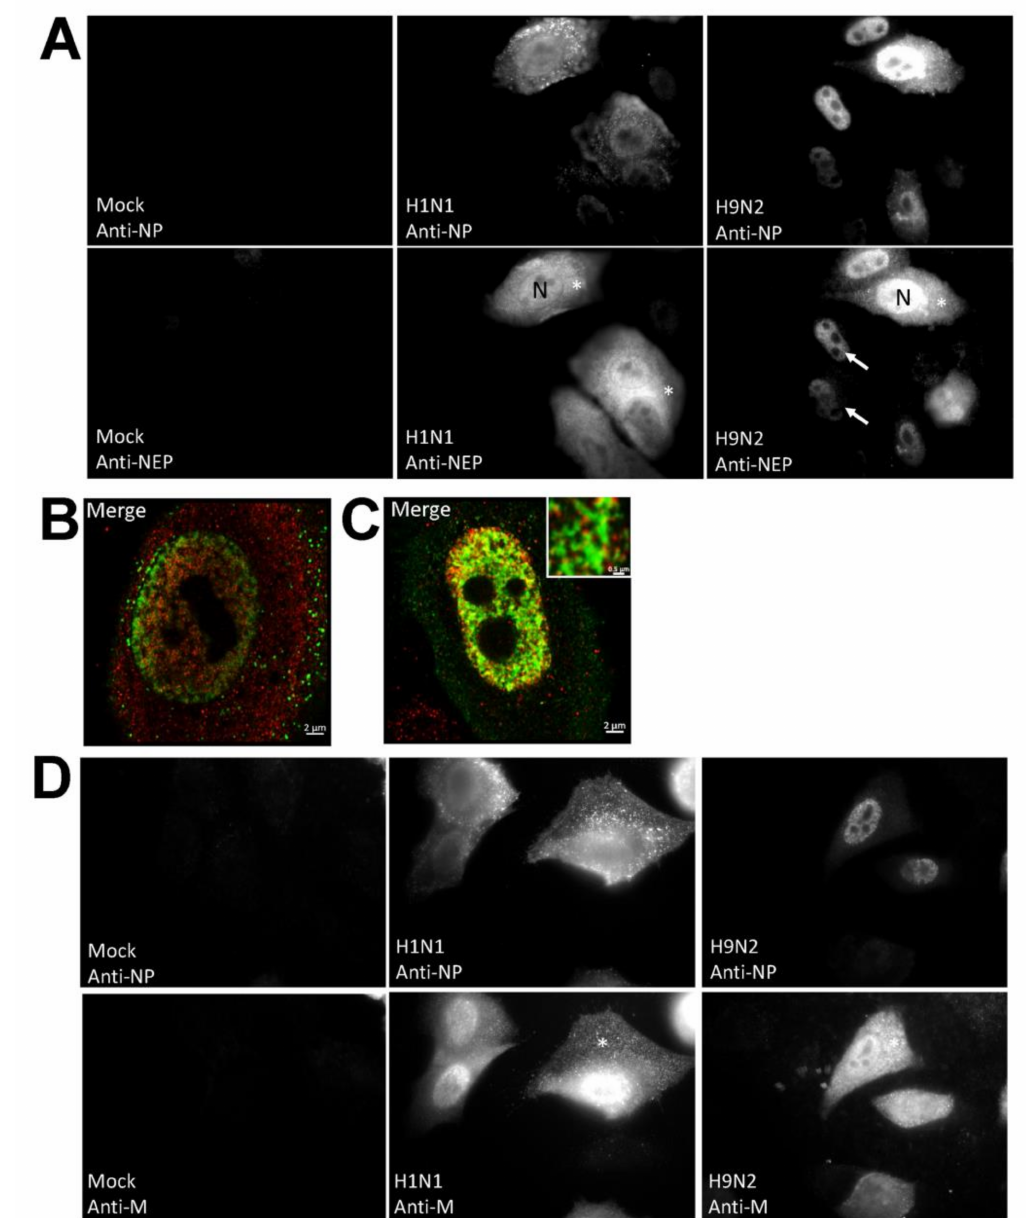
Figure 4. Distribution of the nuclear export protein (NEP) in H1N1 / WSN, and H9N2 influenza virus-infected A549 cells. ( A ) A549 cells were mock-infected or infected with either H1N1 / WSN(H1N1) or H9N2 using an MOI of 5 and at 20 hpi the cells were co-stained using anti-NP and anti-NEP. The cells were imaged by fluorescence microscopy using identical camera settings (objective × 100 magnification). The nucleus (N), nuclear (white arrow) and cytoplasmic (*) anti-NEP staining are highlighted. Individual ( B ) H1N1 / WSN(H1N1) and ( C ) H9N2 virus-infected cells co-stained with anti-NP (green) and anti-NEP (red) were examined in greater detail using confocal microscopy. The merged image is shown in each case. Inset in ( C ) is an enlarged image showing the anti-NP and anti-NEP co-staining in the nucleus of H9N2 virus-infected cells. Bar = 0.5 µ m. ( D ) A549 cells were mock-infected or infected with either H1N1 / WSN(H1N1) or H9N2 were co-stained using anti-NP and anti-M and the cells imaged by fluorescence microscopy using identical camera settings (objective × 100 magnification). The cytoplasmic anti-M staining is highlighted